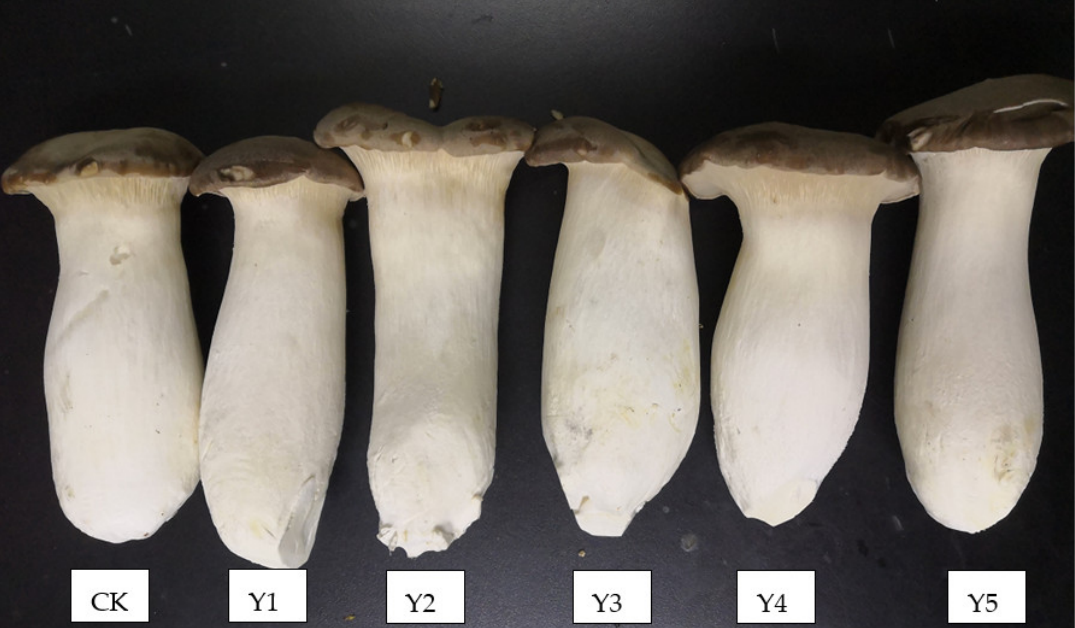
Figure 1. Morphological characteristics of the fruiting bodies of P. eryngii from mycelia that were grown on different substrates. CK: treatment with 21% sawdust and sugarcane bagasse. Y1: treat- ment with 10.5% sawdust and corn stalks and 21% sugarcane bagasse. Y2:treatment with 21% sawdust and 10.5% corn stalks and sugarcane bagasse. Y3: treatment with 21% corn stalks and sugarcane bagasse. Y4: treatment with 21% corn stalks and sawdust. Y5: treatment with 42% corn stalks.